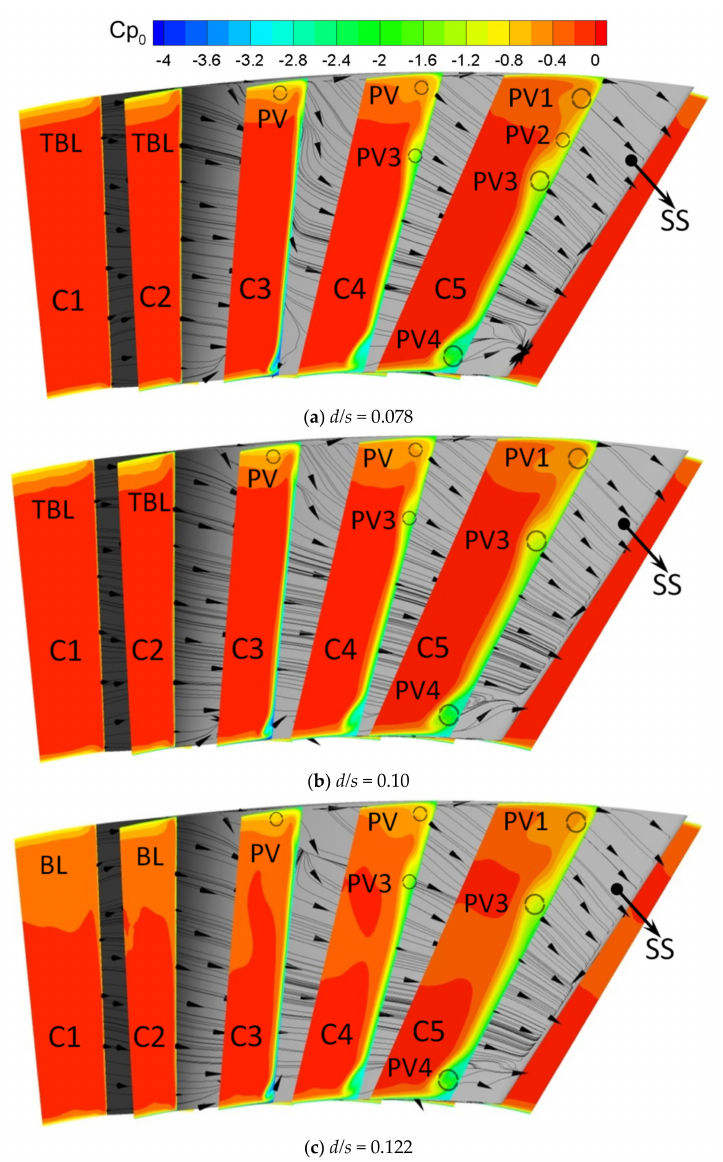
Figure 16. Total pressure coefficient contour of the integrated LPT-GV passages. In the midspan of the LPT-GV, the boundary layer of the suction surface continuously thickened from Section C3 to Section C5 in Figure 16 because of the inverse pressure gradient (as shown in Figure 16). Moreover, with increasing d / s , the boundary layer thickness of the suction surface increased in the same axial section. This result was obtained because the wake could trigger the earlier transition of the boundary layer with increasing d / s , which increased the growth time of the turbulent boundary layer under an inverse pressure gradient. At the root of the LPT-GV with increasing d / s , the decreasing radial pressure gradient, as mentioned above, also weakens the passage vortices in this region (as shown by ‘PV4‘ in Figure 16), which is conducive to reducing the total pressure loss in the corresponding